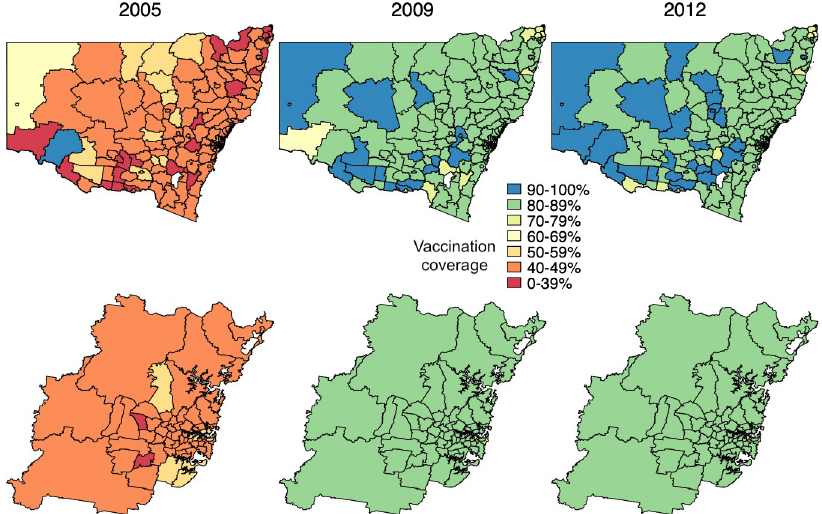
Fig 2. Coverage � of any PCV among children less than 5 years of age by SLA and year, New South Wales, 2001– 2012; top row: New South Wales (state), bottom row: Sydney (capital city); SLAs coloured white have been excluded due to small numbers of children. � Vaccinated defined as 2 or more PCV doses administered at < 12 months of age or at least 1 PCV dose administered after the age of 12 months. SLA digital boundaries (ASGC 2006) for this map were obtained from the Australian Bureau of Statistics (https://www.abs.gov.au/) CC BY 4.0. PCV, pneumococcal conjugate vaccine; SLA, statistical local area.